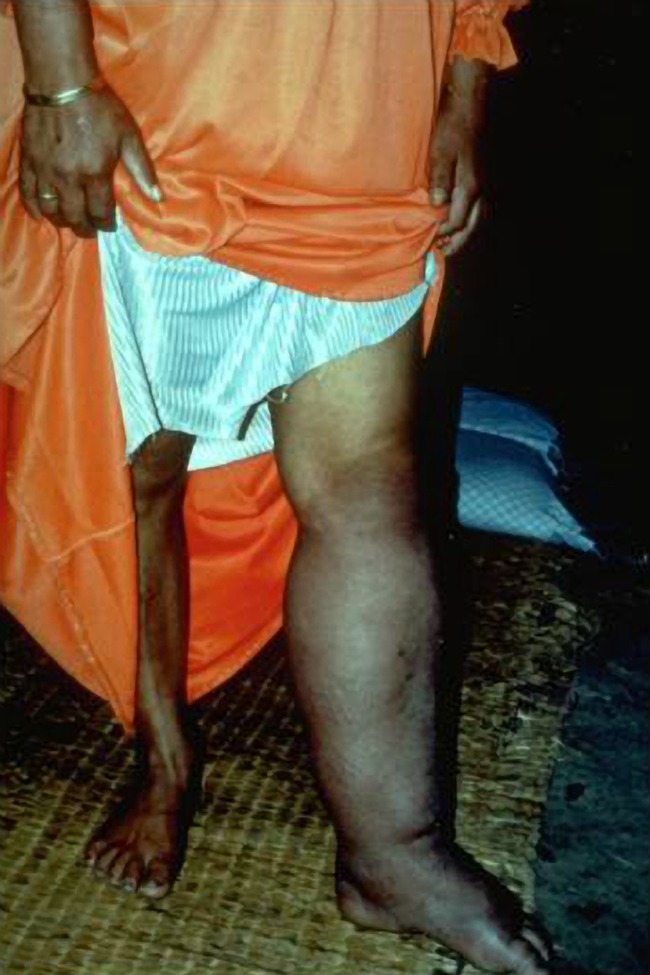
Over a billion people are at risk for infection by filarial nematodes, parasites that cause elephantiasis (Photo: Dr. Steven A. Williams)